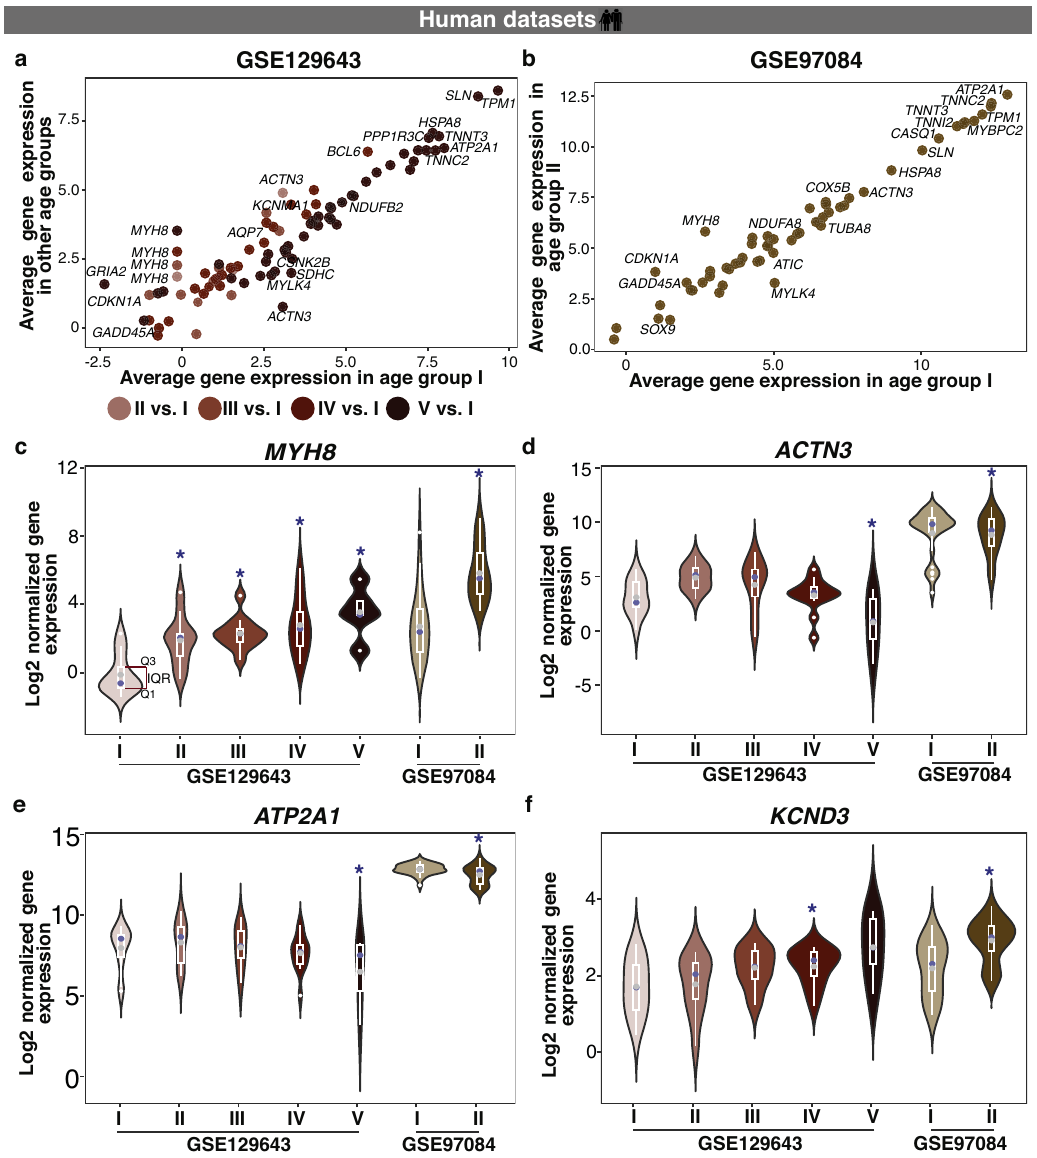
Fig. 5 Aging on Earth results in differential expression of clock- and skeletal muscle-related genes in humans. Bubble plots represent ( a ) the average gene expression for differentially expressed genes in at least one age-group (Age group II = 35 – 49 years, III = 50 – 64 years, IV = 65 – 79 years, and V = 80 + years vs. Age group I = 20 – 34 years; GSE129643), that were also differentially expressed ( b ) in an independent age-related dataset (Age group II = 65 – 75 years vs. Age I = 20 – 30 years, GSE97084). Within the subset of differentially expressed genes of interest ( c ) MYH8 exhibited age associated changes in the expression pro fi le in all age groups vs. age group I (20 – 34 years; GSE129643) and in age group II (65 – 75 years) vs. I (20 – 30 years) in GSE97084 dataset, ( d ) ACTN3 and ( e ) ATP2A1 showed signi fi cant downregulation in the Age group V (80 + years; GSE129643) and in age group II (65 – 75 years; GSE97084) compared to their reference groups, and ( f ) KCND3 showed signi fi cant upregulation in age group IV (65 – 79 years; GSE129643) and in age group II (65 – 75 years; GSE97084) vs. their reference groups (* represents the age groups that showed signi fi cant differential expression vs. reference group; Q1: 1st quartile; Q3: 3rd quartile; top and bottom whiskers: upper and lower adjacent values calculated as Q3 + 1.5IQR and Q1 – 1.5IQR, respectively; grey dots represent the mean value and blue dots represent the median value). pseudocamtodactyly syndrome, a congenital contracture of hands, feet and jaw, as well as hand and foot deformities 76,77 . Whereas, genes like ACTN3 and ATP2A1 were signi fi cantly down- regulated in age group V vs I (GSE129643) and in age group II vs I (GSE97084) datasets (Fig. 5d, e). ACTN3 encodes for alpha-actinin- 3, which plays a major role in skeletal muscle. It is expressed predominantly in fast-twitch, glycolytic muscle fi bres and acts as a binding protein with a structural role at the sarcomeric Z-line. Thus, it in fl uences the force production and force transmission npj Microgravity (2023)